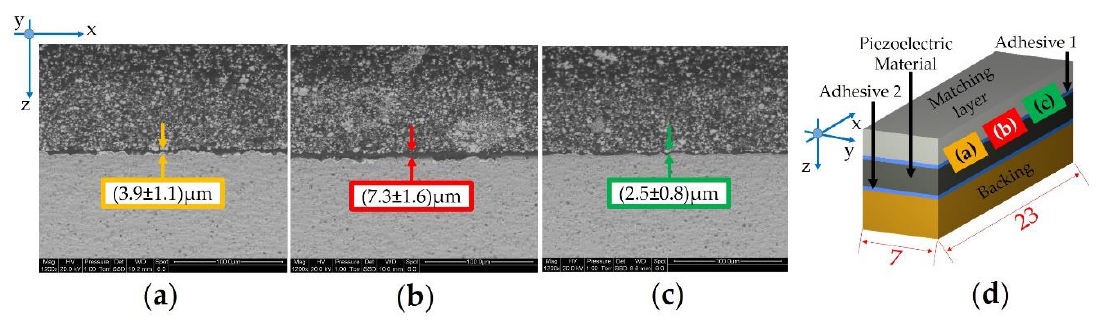
Figure 12. Morphological analysis of the cross section for sample 15,114—lot #1 (not to scale): ( a ) left side; ( b ) central part; ( c ) right side; ( d ) cross section of the acoustic stack.